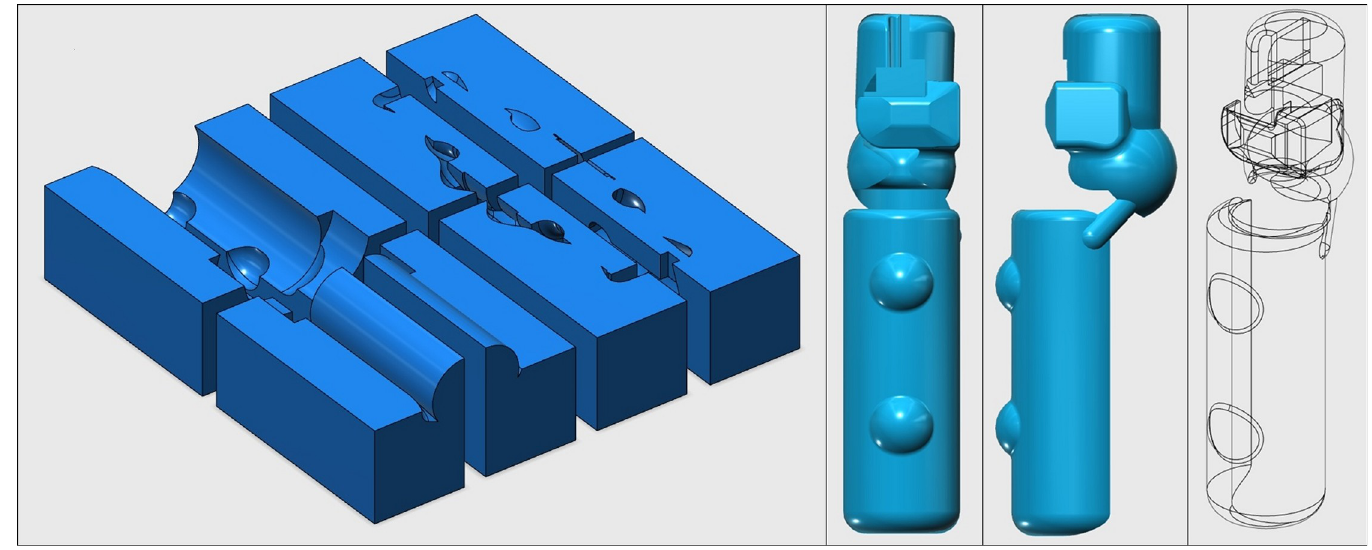
Fig 1. Designed ergonomic laryngoscope grip model.